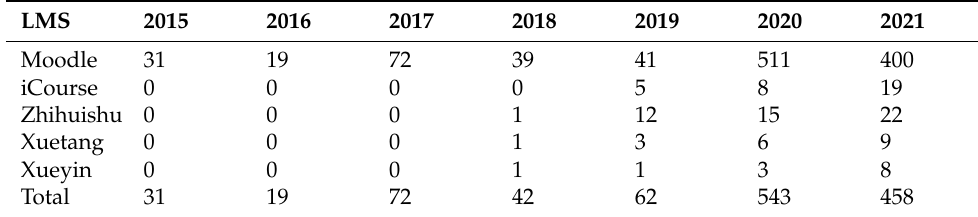
Table 2. Number of S university’s BL courses based on SPOC/MOOC.